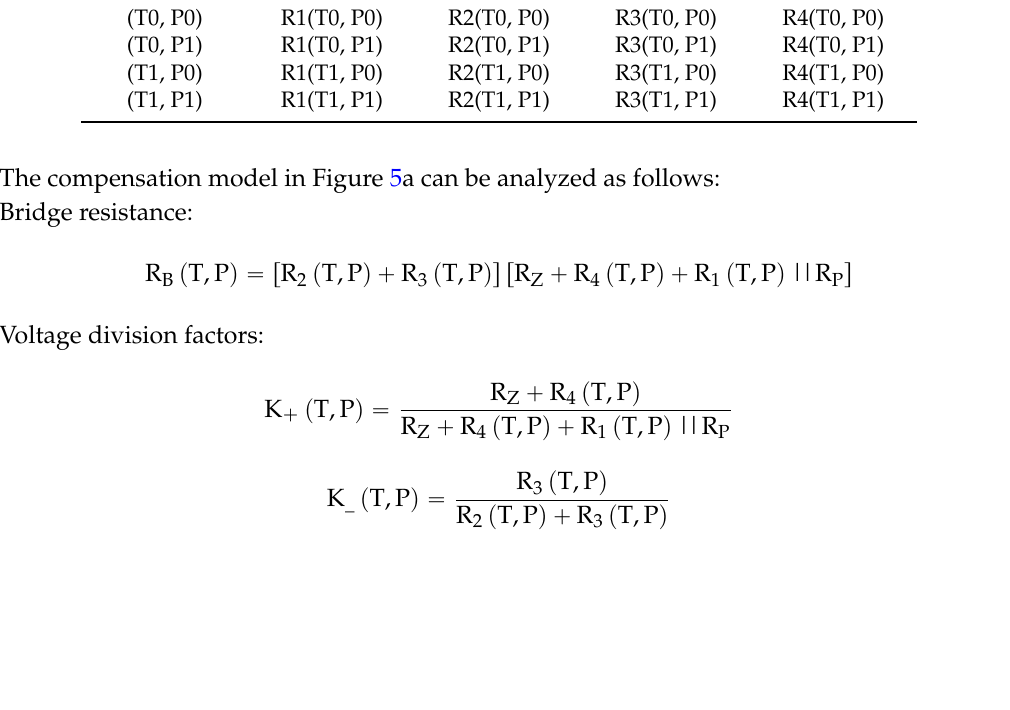
Table 1. Measurement parameters for compensation model.